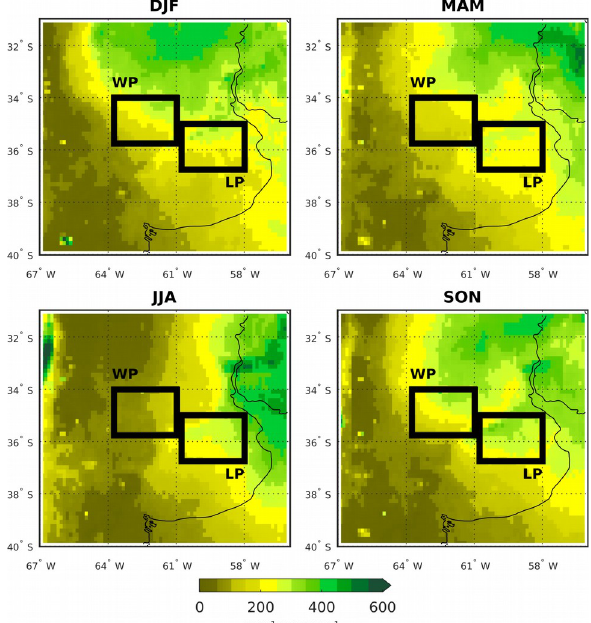
Figure 2. Seasonal mean of TRMM precipitation (mm 1 season -1 ) for the region of interest during 2000-2014. The subregions Western Pampa (WP) and Lower Pampa (LP) are indicated with black